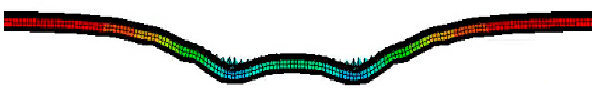
Figure 22. Cloud diagram of rail deformation under double-axis load.